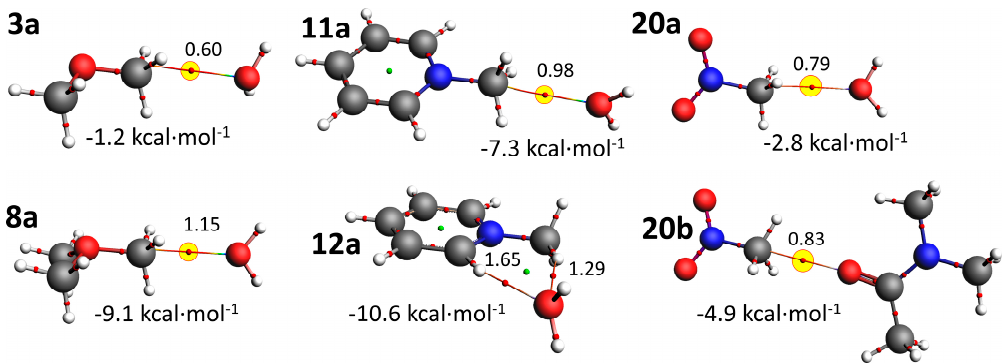
Figure 5. Ball and stick representations of molecular adducts selected from Table 1 that were optimized by DFT (B3LYP-D3 / def2-TZVP). The thin lines are bond paths (bp’s) and the small red spheres are bond critical points (bcp’s) obtained from an ‘atoms-in-molecules’ analysis. The bond density ( ρ ) is in arbitrary units · 10 2 and bcp’s indicative of non-covalent Carbon bonding have been highlighted in